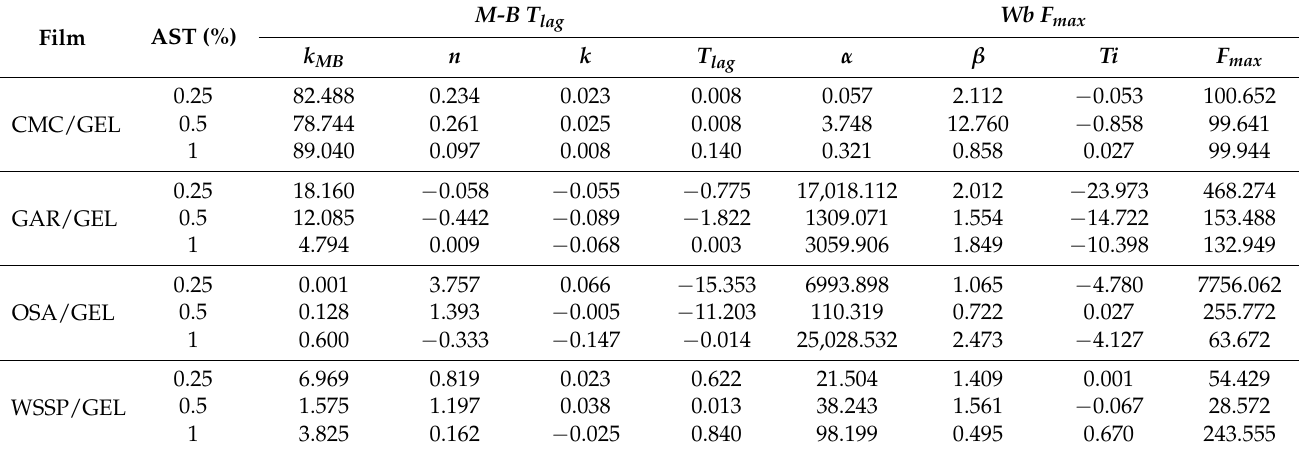
Table 6. Kinetic parameters obtained from four-parameter